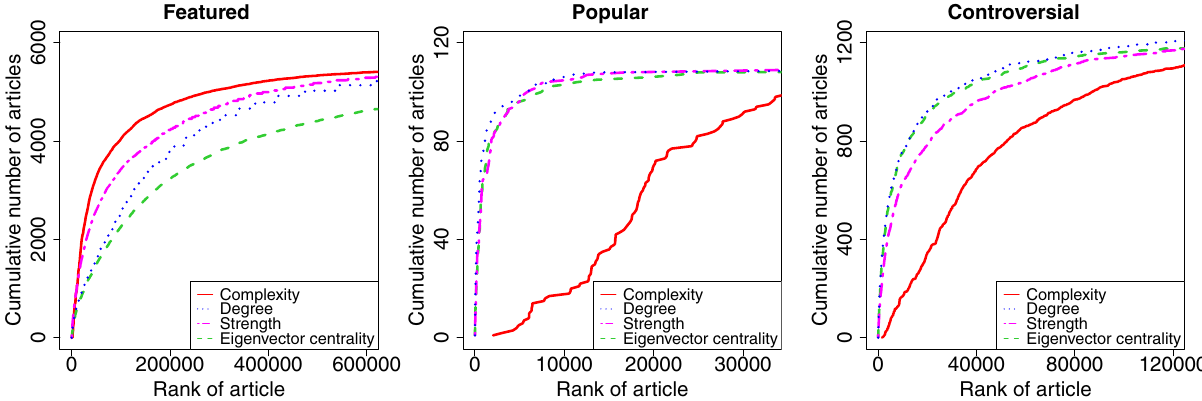
Figure 2. Cumulative number of “featured”, “popular”, and “controversial” articles contained in the top-ranked or top-N hit articles for Complexity, Degree, Strength, and Eigenvector centrality measures. The Complexity works best for finding the “featured” articles, while it picks the “popular” articles and the “controversial” articles more selectively, than the other measures.